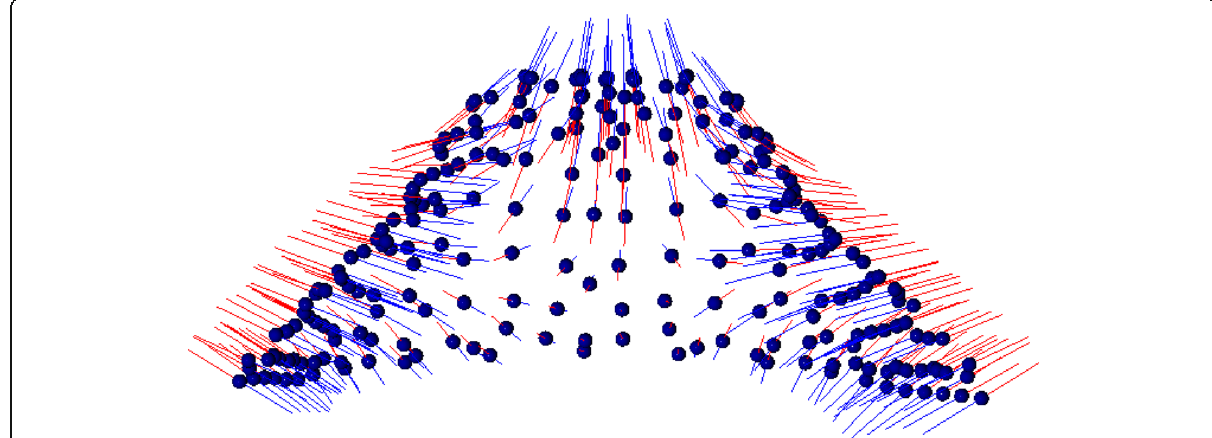
Fig. 3 On the left, PC1 resulted into 50% of variability source: the main difference consisted of a larger and shorter palatal vault height vs a narrower and higher palate. Blue lines show the trend of mouth breathers; red lines show the trend of nasal